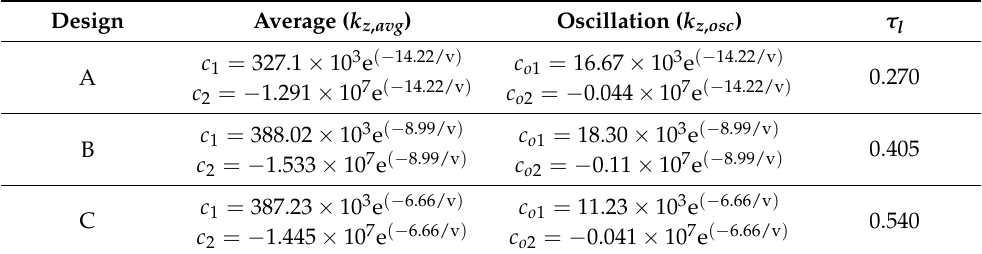
Table 5. Coefficients of levitation stiffness (average and